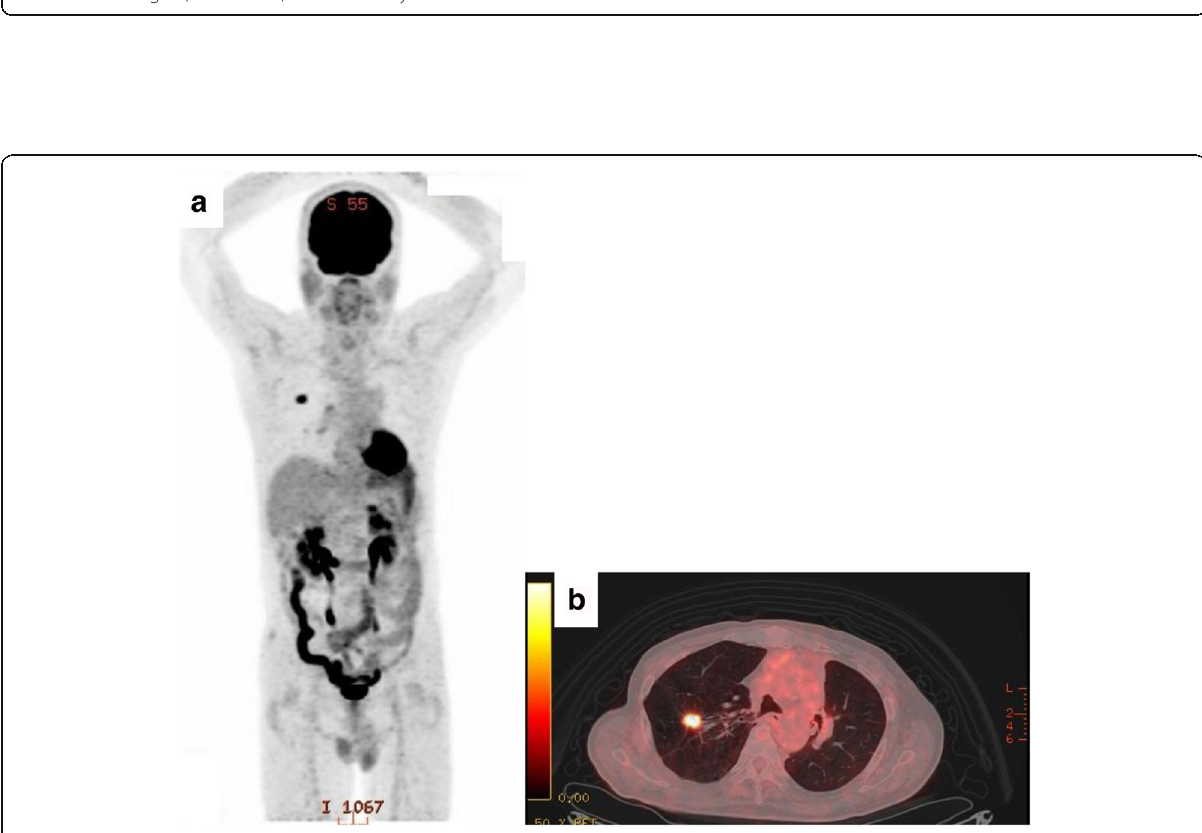
Fig. 3 a Positron emission tomography (PET) showing accumulations of fluoro-deoxy-glucose (FDG) with the maximum standard uptake value of 7.2 in the residual right upper lobe and that of 2.6 in the right hilum. b PET/computed tomography (CT) showing accumulation of FDG in the solid nodule on this cut-end